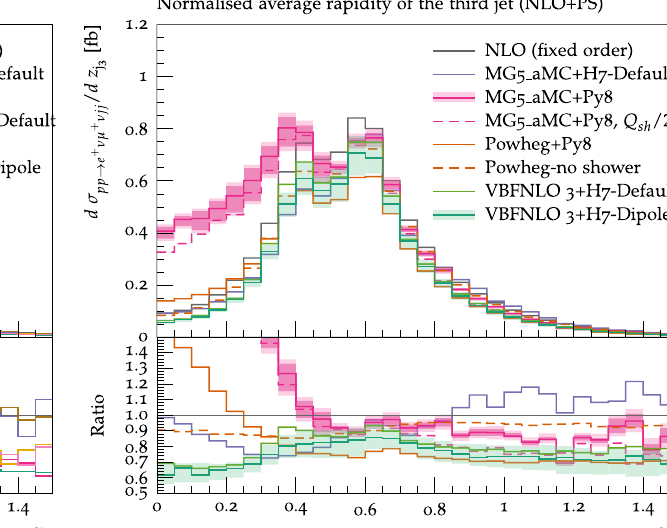
shown, while for MG5_aMC + Pythia8 the darker and lighter bands correspond respectively to the nine-point scale uncertainty and the scale and PDF uncertainties combined linearly. The predictions are obtained in the fiducial region described in Sect.